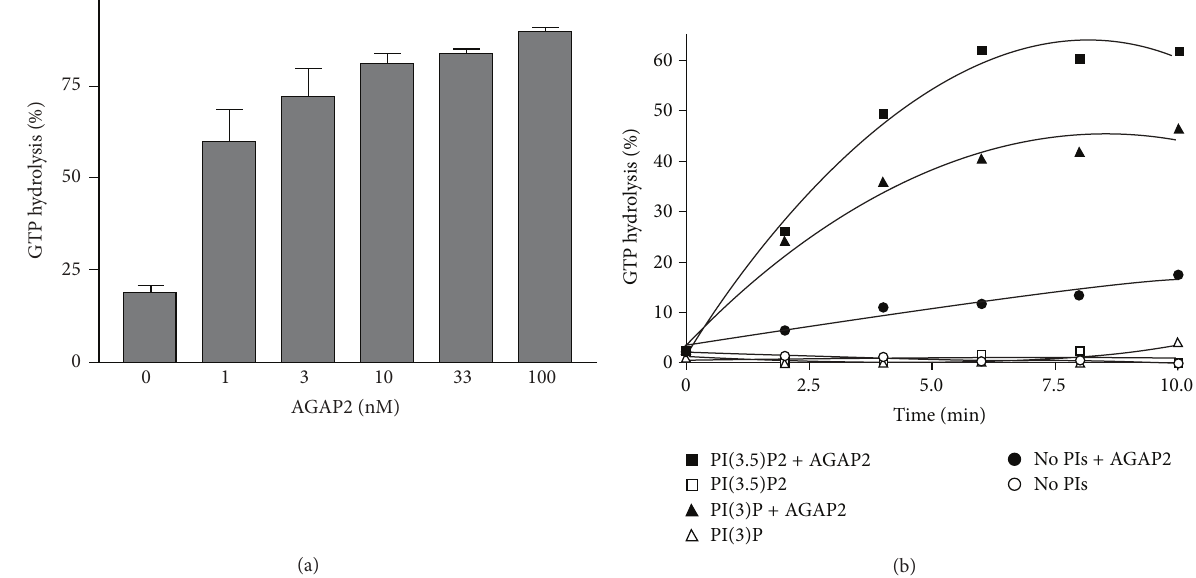
Figure 4: AGAP2 efficiently stimulates GTP hydrolysis on Arf1 and GAP activity is stimulated by products of PI3K, PtdIns(3)P, and PtdIns(3,5)P 2 . Recombinant myristoylated Arf1 was purified from E. coli as previously described [20]. AGAP2 cDNA was inserted into the pACHLT-A baculovirus shuttle vector and cotransfected with linearized BaculoGold viral DNA into sf9 cells. Culture supernatants were used to infect sf9 cells with an MOI of 10. Insect cells were collected 48h after infection and His6-AGAP2 was purified from sf9 lysates by chromatography on Ni-trap columns. (a) GTP 𝛼 32 P was loaded onto Arf1 in the presence of 1mg/mL of liposomes composed of phosphatidylcholine, phosphatidylethanolamine, and phosphatidylserine (molar ratio 40.55 : 31: 28.45) for 30 min at 30 ∘ C. AGAP2 at the indicated concentrations was mixed with 0.3 𝜇 M GTP 𝛼 32 P-loaded Arf1 and incubated for 30 min at 30 ∘ C in GAP buffer (20mM Tris pH 8.0, 2 mM DTT, 100 mM NaCl, 1 mM MgCl 2 , and 100 𝜇 g/mL liposomes). (b) GTP 𝛼 32 P was loaded onto Arf1 in the presence of 1mg/mL of liposomes composed of phosphatidylcholine, phosphatidylethanolamine, phosphatidylserine (molar ratio 40.55 : 31: 28.45), and liposome- supplemented PtdIns(3)P or PtdIns(3,5)P 2 (molar ratio 37.4 :28.5 :26.2 : 7.9) for 30 min at 30 ∘ C. AGAP2 (10nM) was mixed with 0.3 𝜇 M GTP 𝛼 32 P-loaded Arf1 and incubated at 30 ∘ C in GAP buffer for indicated time points. Reactions were stopped by dilution in ice-cold stop buffer (20 mM Tris pH 8.0, 1mM DTT, and 10mM MgCl 2 ). Samples were filtered on Gelman GN-6 membranes and bound nucleotides were eluted with 2 M LiCl. GTP was separated from GDP by chromatography using polyethylenimine cellulose TLC plates developed in 1M LiCl/1M formic acid. The GTP 𝛼 32 P/GDP 𝛼 32 P ratios were calculated after exposure of TLC plates to a